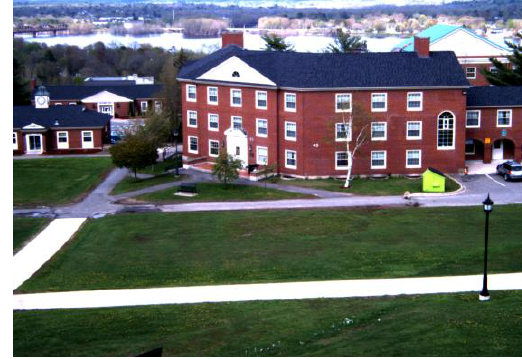
Figure 4: Scene 1 of the study areas Scene 2 consist of an athletic field with turf coverage and vegetation. The difference between turf and vegetation in NIR band is highlighted and can demonstrate the value of NIR band in UAV image classifications. Figure 5 shows a screenshot of Scene 2.